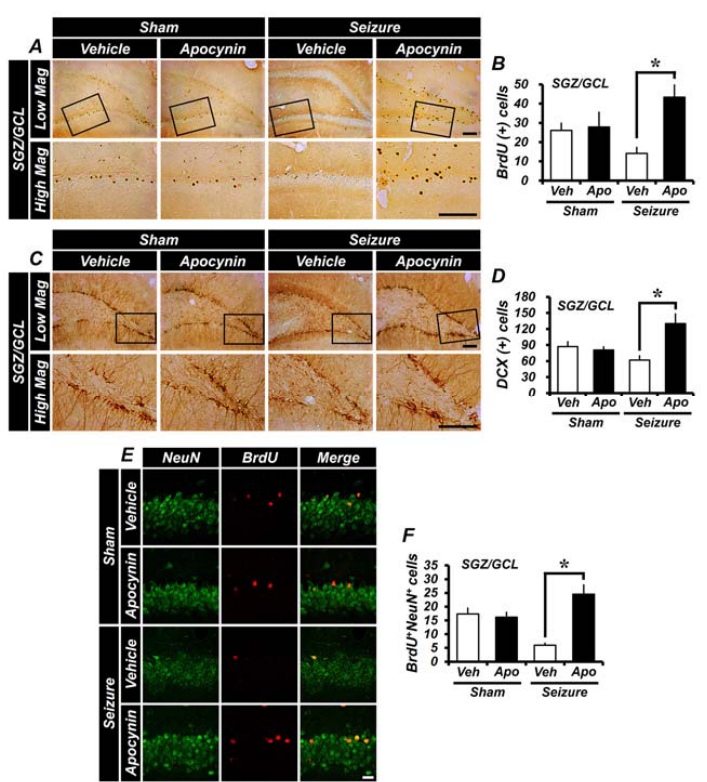
(Figure 6C,D). BrdU and NeuN double staining was performed to determine whether the proliferating cells were differentiated into mature neurons. It was confirmed that the number of BrdU + NeuN + cells labeled 4 weeks after seizures was decreased. Apocynin was injected for 4 weeks after seizures and the number of differentiated mature neurons among surviving cells was higher than in the vehicle group (Figure 6E,F).